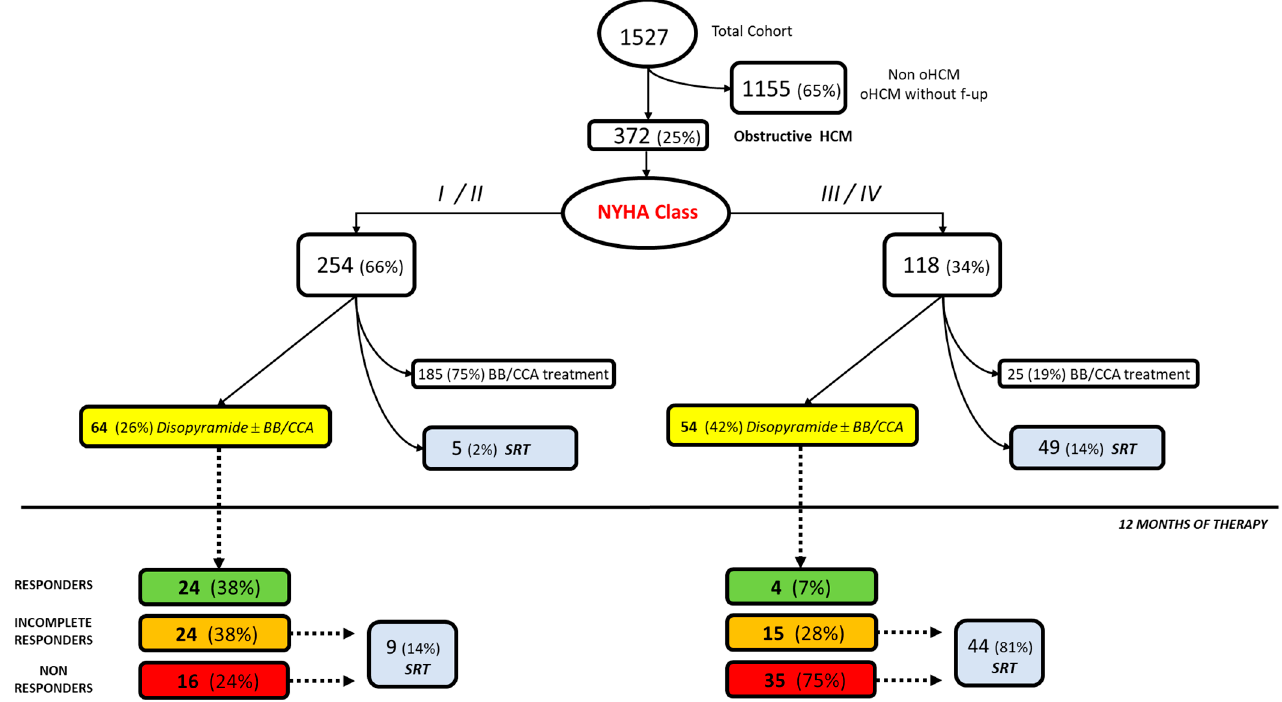
Figure 1. Clinical management of patients with obstructive hypertrophic cardiomyopathy. Abbrevi- ations: oHCM: obstructive hypertrophic cardiomyopathy; f-up: follow-up; BB: beta-blockers; CCA: calcium antagonists; SRT: septal reduction treatments.